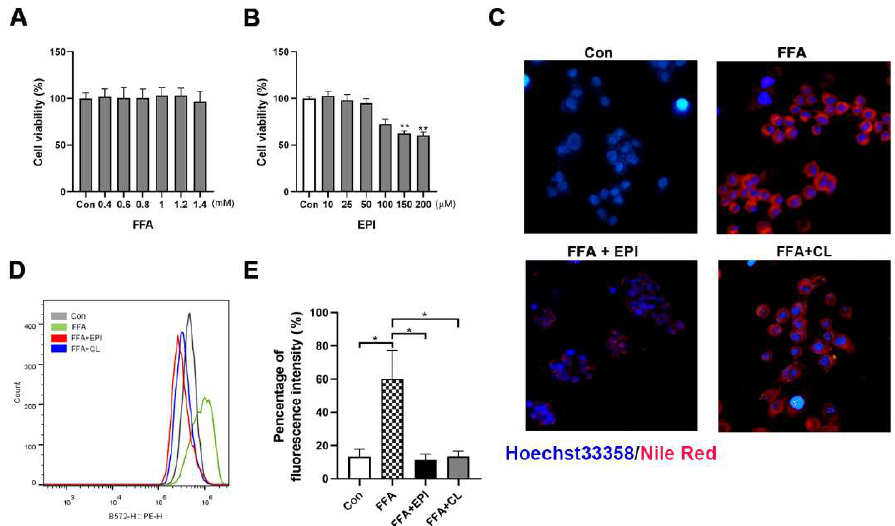
Figure 1. EPI (EPI-001) prevents hepatic lipid accumulation in human hepatic cells. ( A ) CCK8 assay was used to detect the cytotoxicity of free fatty acids (FFAs) in the WRL68 cell line; ( B ) The cytotoxicity of EPI was detected in the WRL68 cell line by using CCK8 assay; ( C ) Representative images of the lipid accumulation (red stained by Nile red) after the treatment of FFAs and EPI-001 (25 µ M)/clofibrate (CL) (200 µ M) in the WRL68 cell line (400 × magnification); ( D ) Nile red fluores- cence was detected by flow cytometry (FCM), shown is a representative result from three independent experiments; ( E ) Quantification of FCM. (mean ± SEM, * p < 0.05, ** p < 0.01). Shown are results from at least three independent